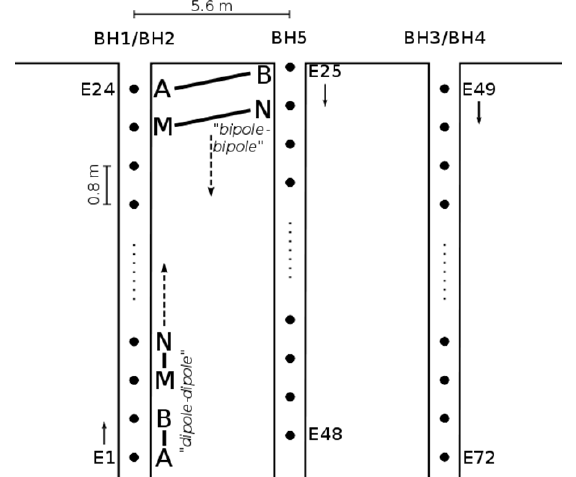
Figure 4. Schematic description of the ERT measurement configu- rations used. For dipole–dipole measurements, one dipole is always within one borehole, the other dipole also moves into the adjacent borehole. Bipole–bipole measurements are done as cross-hole mea- surements and are also changing as diagonals (i.e., A stays while B moves downwards for up to five electrode positions before A is also moved, similarly for M and N).